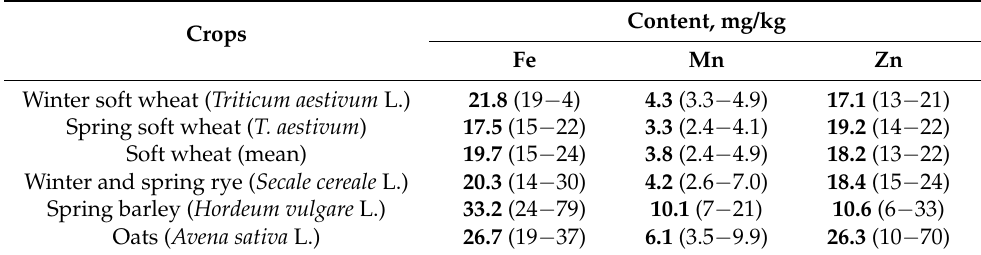
Table 1. Average values and ranges for the content of micronutrients (Fe, Mn, Zn) in caryopses of cereal crops [3]. Content, mg/kg Crops Fe Mn Zn Winter soft wheat ( Triticum aestivum L.) 21.8 (19 − 4) 4.3 (3.3 − 4.9) 17.1 (13 − 21) Spring soft wheat ( T. aestivum ) 17.5 (15 − 22) 3.3 (2.4 − 4.1) 19.2 (14 − 22) Soft wheat (mean) 19.7 (15 − 24) 3.8 (2.4 − 4.9) 18.2 (13 − 22) Winter and spring rye ( Secale cereale L.) 20.3 (14 − 30) 4.2 (2.6 − 7.0) 18.4 (15 − 24) Spring barley ( Hordeum vulgare L.) 33.2 (24 − 79) 10.1 (7 − 21) 10.6 (6 − 33) Oats ( Avena sativa L.) 26.7 (19 − 37) 6.1 (3.5 − 9.9) 26.3 (10 −